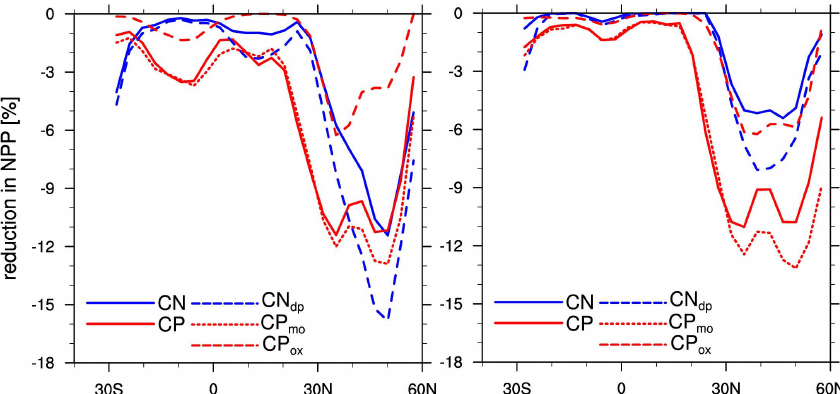
Fig. 5. Mean reduction of NPP (%) due to CNL (N or P) averaged over 30yr (2070–2099 (left) and 2320–2349 (right)) as latitudinal means. Solid line are results from the CN and the CP simulation for N and P limitation, respectively. The dashed lines are results from the sensitivity experiments CP ox , CP mo , and CN dp